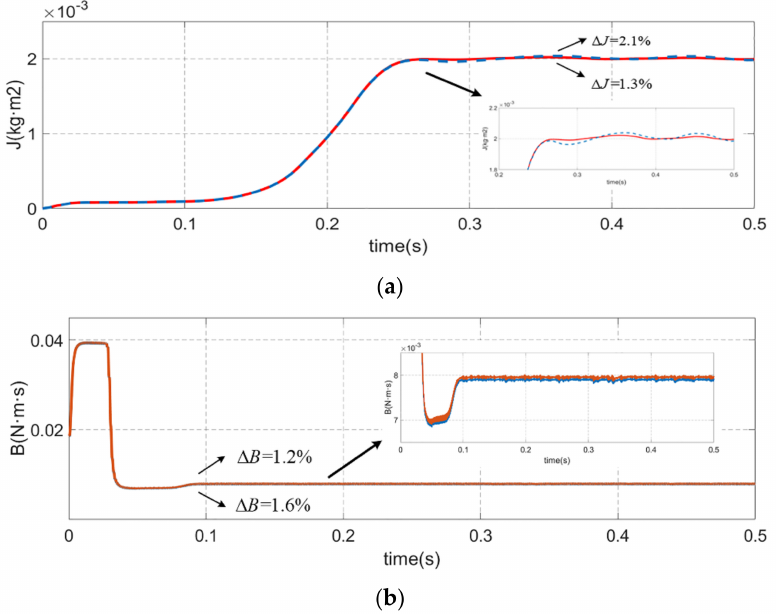
Figure 10. Comparison of inertia and friction coefficient identification results at the sinusoidal reference speed of 10 Hz, 1500 r/min which the blue line represents the single improved integra- tion method and red line represents the improved integration method combine with IGSA-IPNN. ( a ) moment of inertia. ( b ) viscous friction